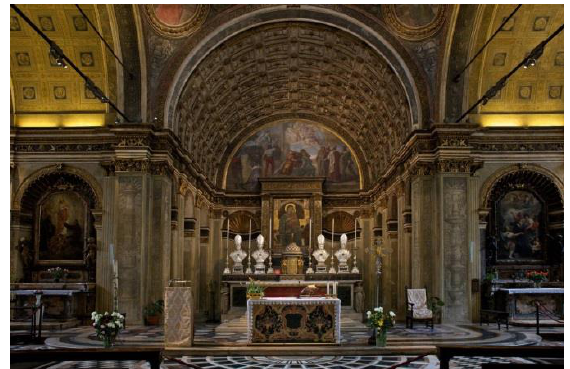
Fig. 13 Saint Satyrus Church (Milan,